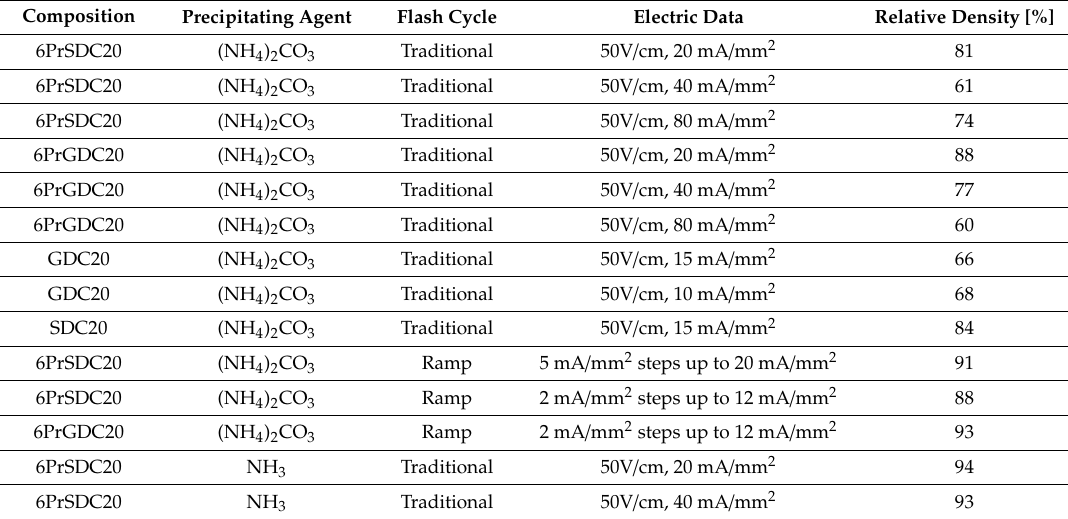
Figure 9. SEM micrographs of sintered SPDC-NH3 at 50 V/cm and 20 mA/mm 2 ( a , b ) and 40 mA/mm 2 Figure 9. SEMmicrographsofsinteredSPDC-NH3at50V / cmand20mA / mm 2 ( a , b )and40mA / mm 2 ( c , d ). ( c , d ). Table 1. Summary of the di ff erent treating conditions and final densities achieved in this Table 1. Summary of the different treating conditions and final densities achieved in this work.